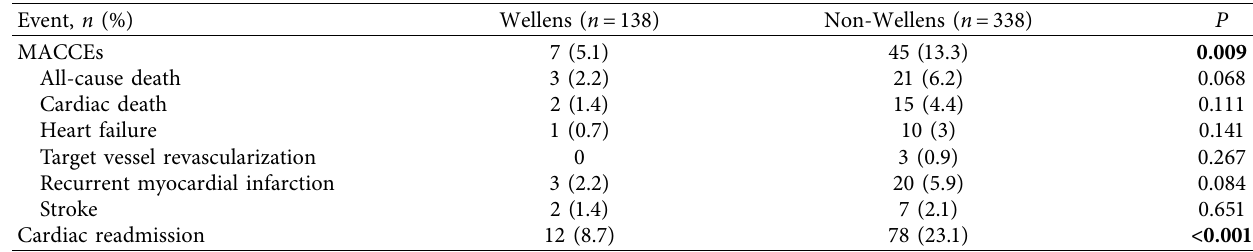
Table 3: Comparison of clinical outcome between Wellens and non-Wellens groups.